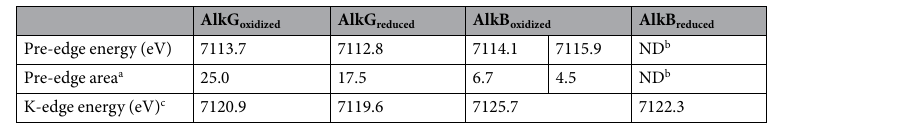
Table 1. Results obtained from pre-edge spectra of AlkG oxidized , AlkG reduced , AlkB oxidized and AlkB reduced . a The integrated area is reported in unit, which is the real value multiply by 100 39–41 . b ND: Not detected due to the poor resolution of the spectrum after linear combination. c K-edge energy 41 (eV) is defined herein as the energy at half its maximum normalization intensity for the rising edge of normalized XANES